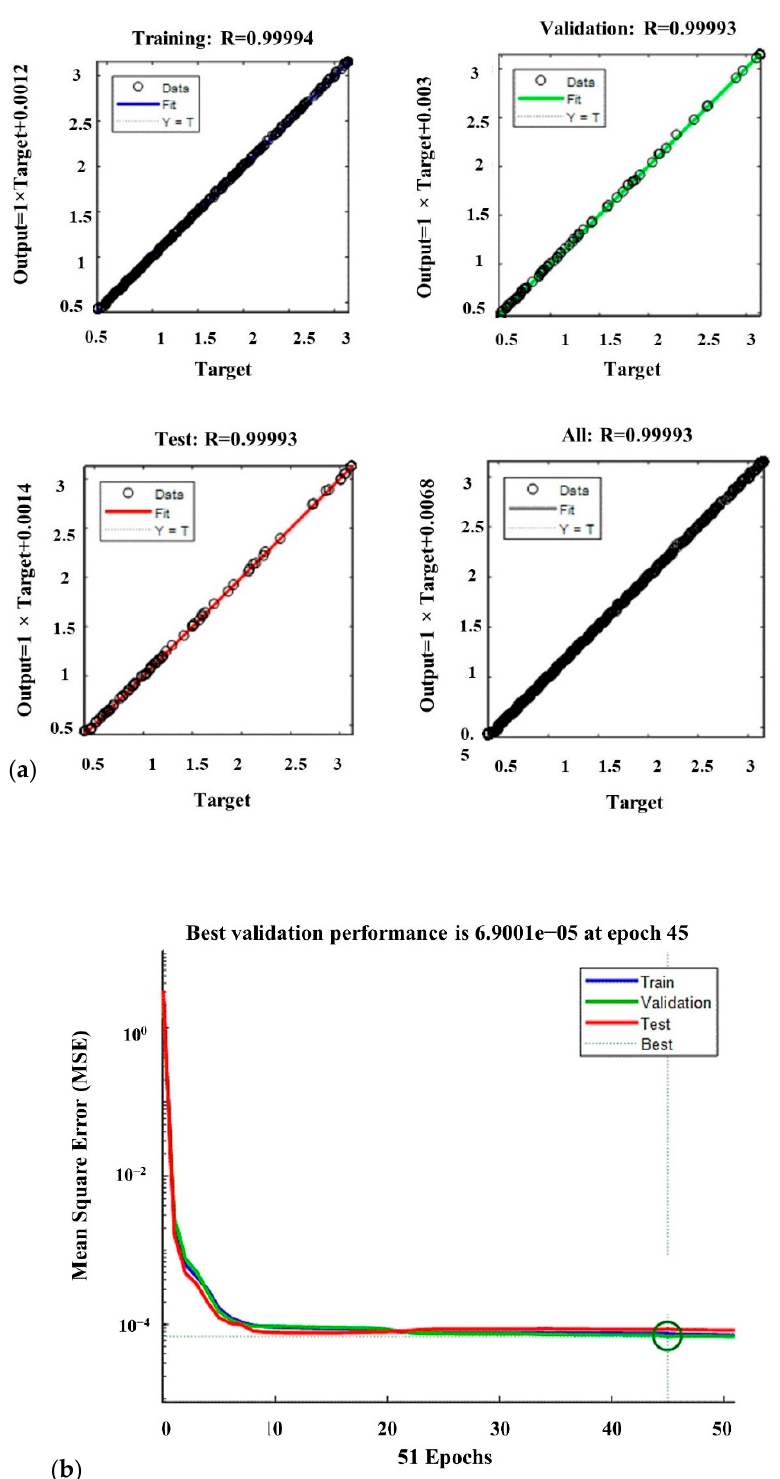
Figure 11. ( a ) Approximation capability of the trained neural network and ( b ) mean squared error of the finger’s force.